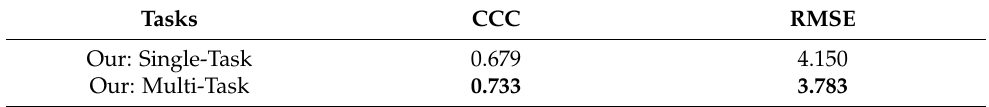
Table 3. Comparison between single-task and multi-task with metrics of CCC, RMSE. Single-Task includes the PHQ-8 regression task while Multi-Task includes the PHQ-8 regression task and the 5-class classification task. The data in bold means the results with better